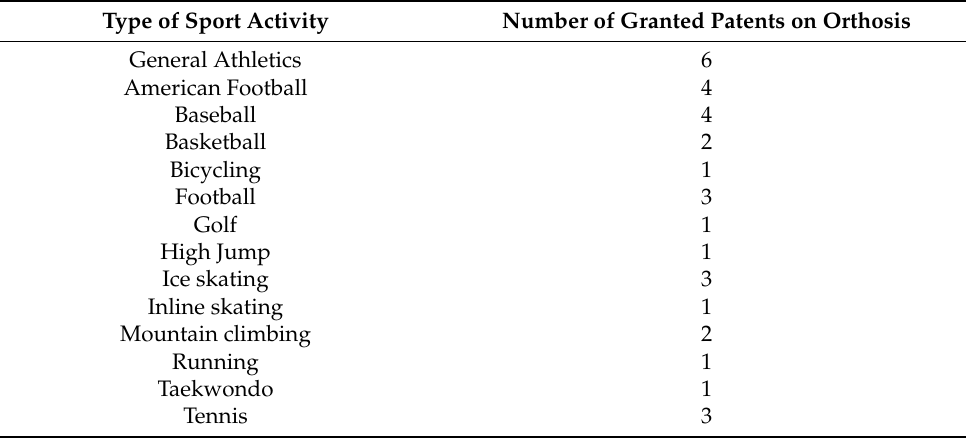
Table 4. The number of granted orthosis patents associated with the type of sport.